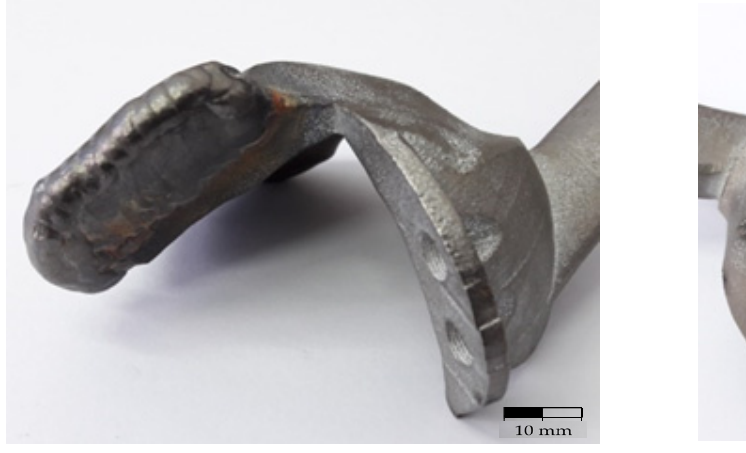
Figure 7. Custom implant subjected to the welding deposition process to restore the geometric char- acteristics prescribed by the 3D model. ( a ) front view; ( b ) back view.